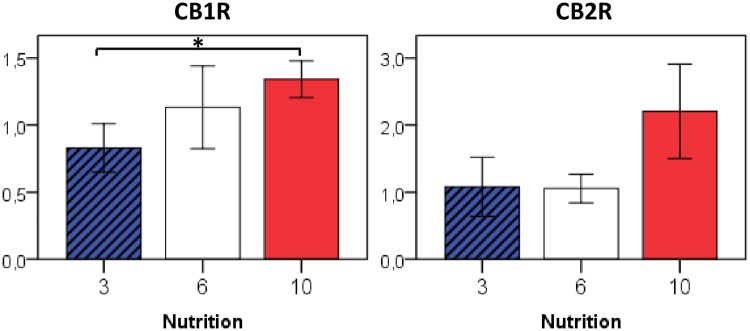
Relative gene expression of eCB receptors in the hypothalamic arcuate nucleus at P50 in relation to early postnatal nutrition.n = 4–5 males per nutrition group, * p<0.05 (ANOVA).